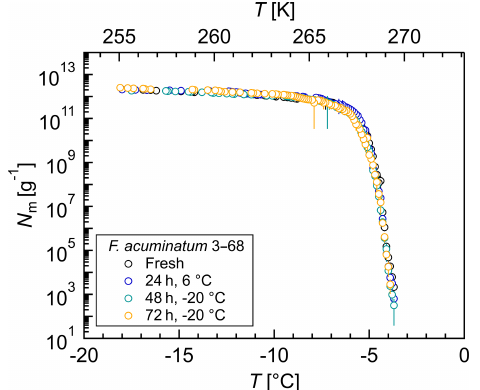
Figure 5. Effects of short-term storage and freeze–thaw cycles on the ice nucleation activity of Fusarium acuminatum 3–68: cumu- lative number of IN ( N m ) per gram of mycelium plotted against the temperature ( T ). The same aqueous extract was measured im- mediately after preparation (black), after storage at 6 ◦ C for 24h (blue), after another 24h stored at − 20 ◦ C (total 48h; turquoise), and after another 24h stored at − 20 ◦ C (total 72h; yellow). The er- ror bars were calculated using the counting error and the Gaussian error